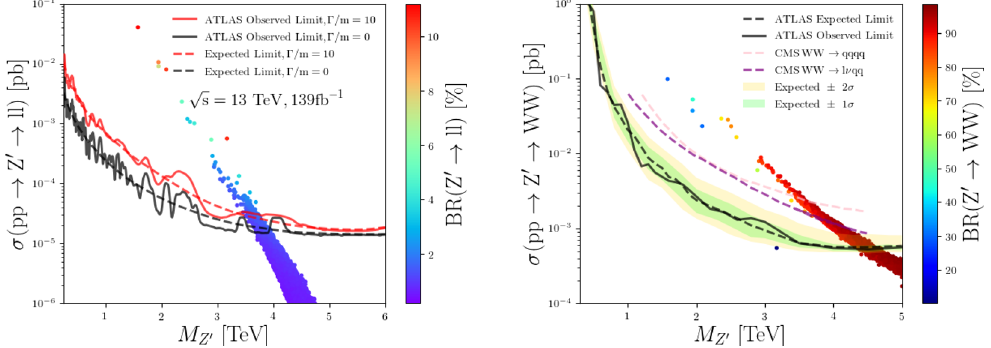
Figure 1 . The Z 0 boson mass limits on (cid:27) ( pp ! Z 0 ! ll ) vs M Z 0 (left panel) and (cid:27) ( pp ! Z 0 ! WW ) vs M Z 0 (right panel). The experimental exclusion curves obtained by the ATLAS [40, 83] and CMS [84, 85] collaborations are showed against the results of our scan colour coded in terms of the relevant Z 0